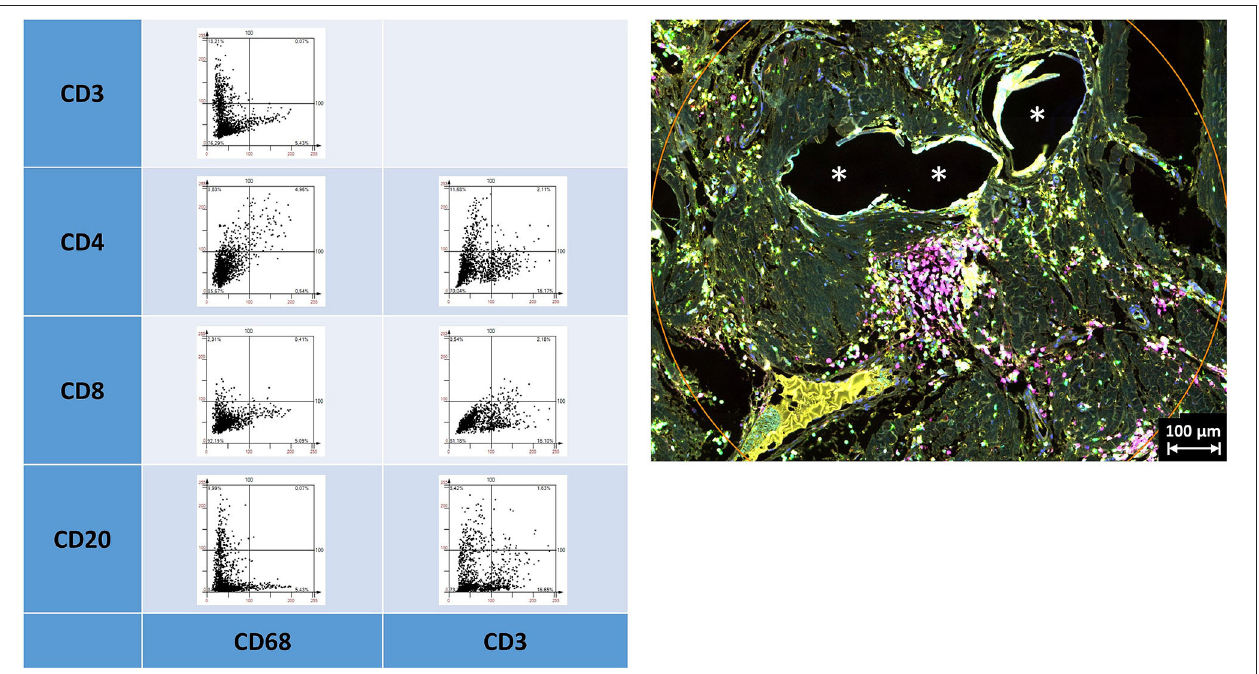
FIGURE 5 | Examples of linear scatter plots from lymphocyte panel. Scatter plots of mean cellular intensities of two markers in a 1 mm 2 ROI placed around PP mesh fibers. Lines in the scatter plot mark the cut-off value 100. Cytometric analysis was performed with StrataQuest 7. Asterisks mark fiber locations.